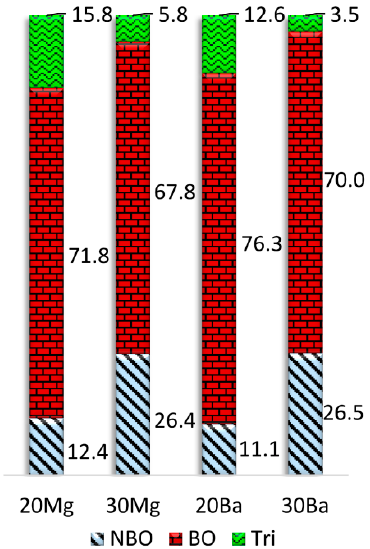
Figure 3. Fractions of non-bridging oxygen (NBO), bridging oxygen (BO), and tricluster oxygen ions (Tri) as a function of chemical composition.